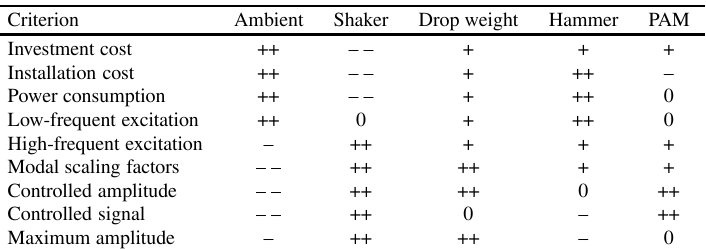
Table 1 Comparison of excitation